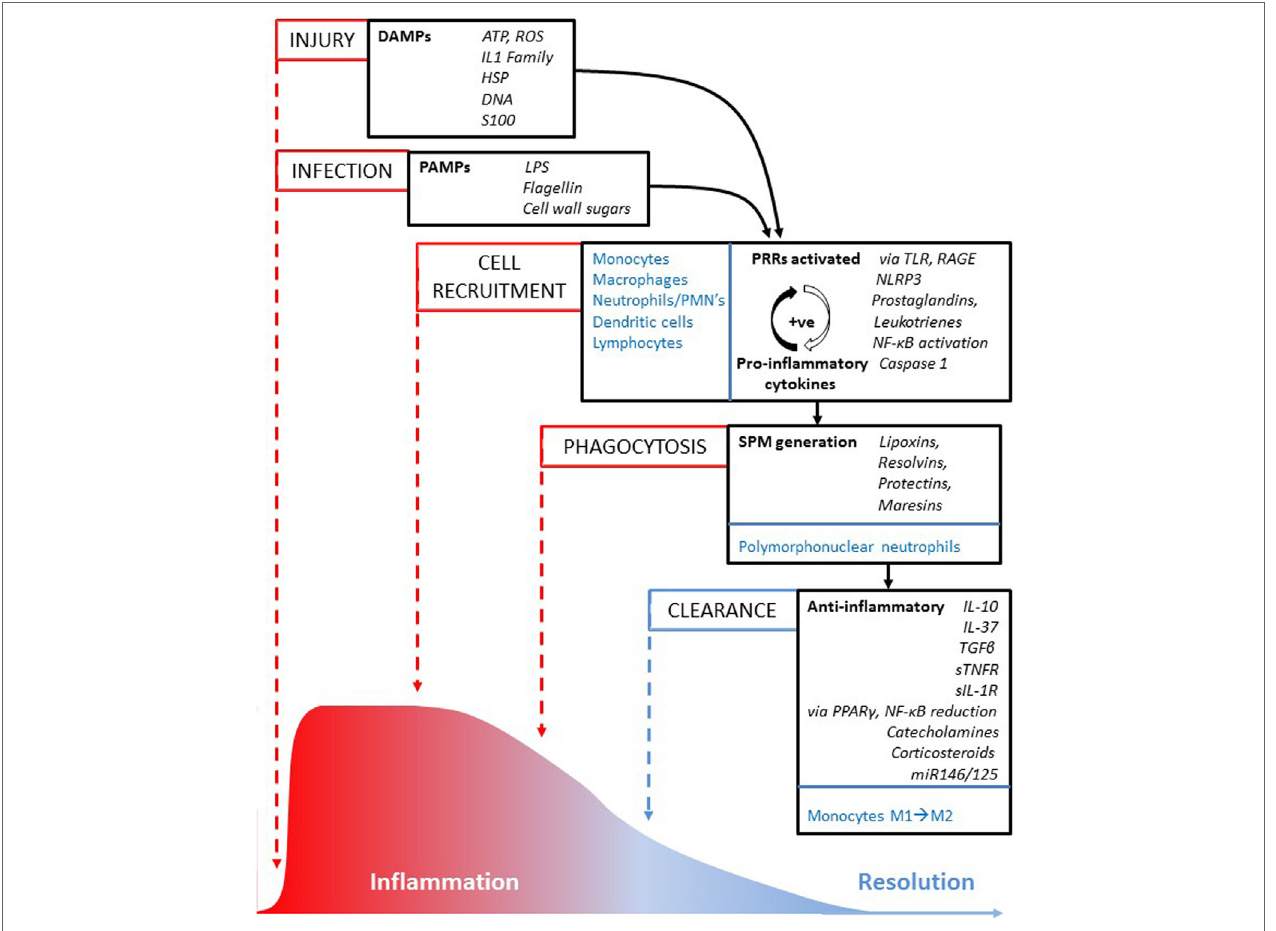
FigURe 1 | Inflammation pathway to resolution. An illustration of the sequence of key processes (in capitalized text), cells and molecules involved in reaction to injury or infection, and how the inflammatory episode is resolved over time (from left to right). Cells from the innate and adaptive immune system that are involved in cell recruitment, phagocytosis, and clearance processes are highlighted in blue text; key molecules are in italic